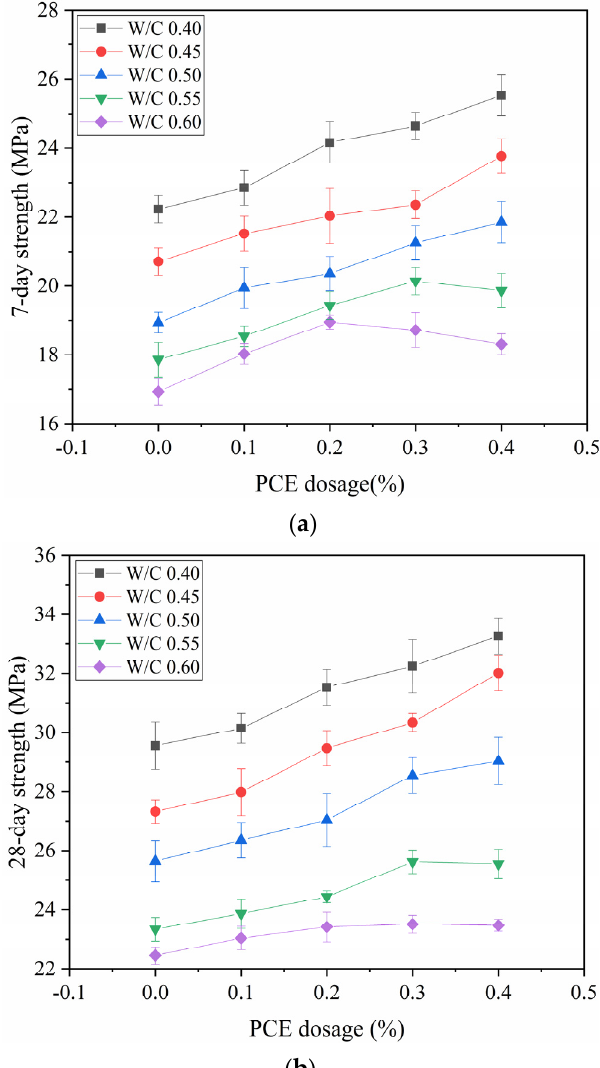
Figure 8. Strength versus PCE Dosage: ( a ) 7-Day Strength, ( b ) 28-Day Strength.